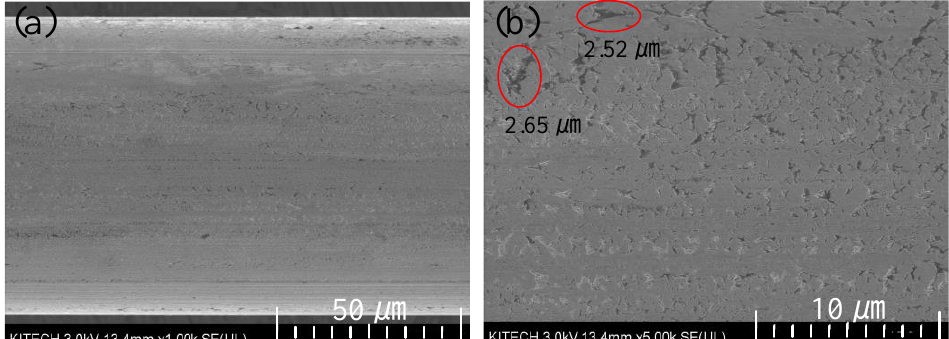
Figure 12. SEM image of the initial wire. ( a ) × 1000 ; ( b ) × 5000 .